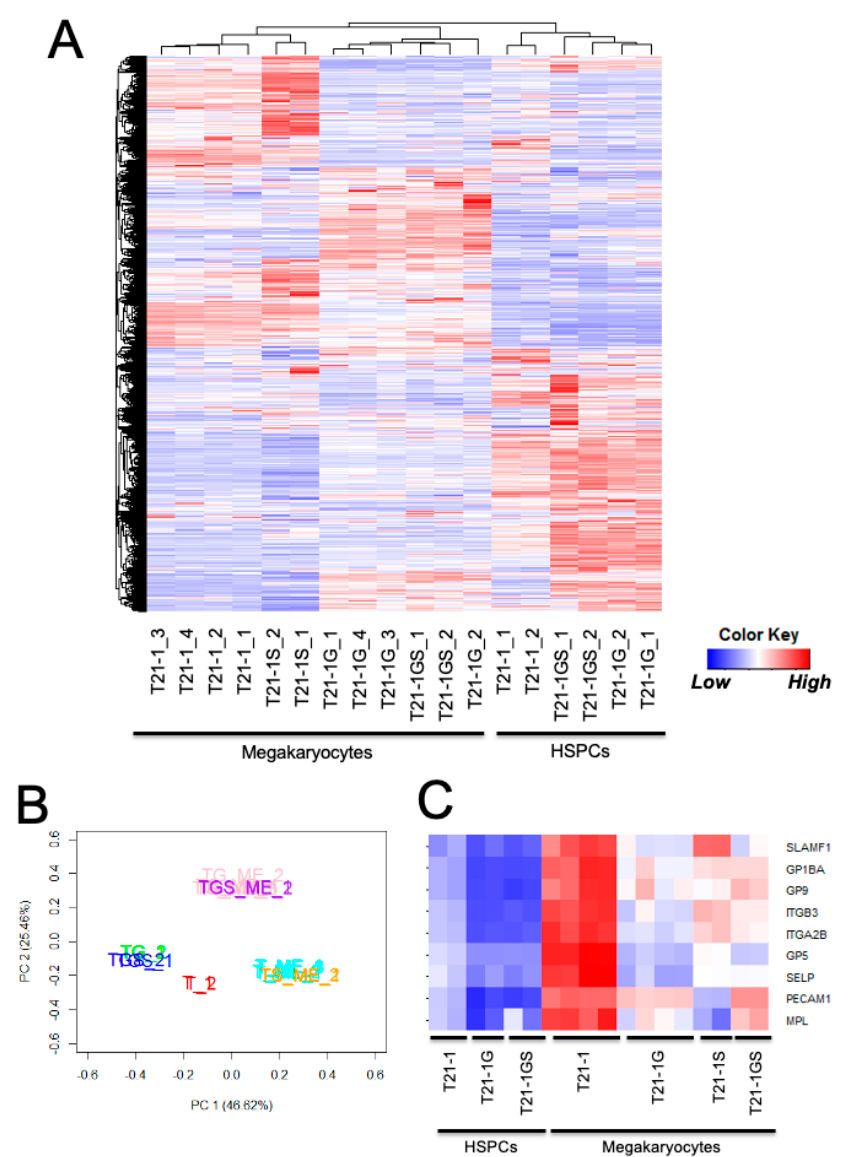
Figure 4. ( A ) Heatmap showing the unsupervised hierarchical clustering of all samples. ( B ) Principal component analysis of the indicated samples. T21-1 HSPCs (T_1,2 in red), T21-1G HSPCs (TG_1,2 in green), T21-1GS (TGS_1,2 in blue), T21-1 megakaryocytes (T_ME_1,2 in teal), T21-1G megakaryocytes (TG_ME_1,2 in pink), T21-1S (TS_ME_1,2 in yellow), T21-1GS (TGS_ME_1,2 in magenta). All genes were used for both analyses. ( C ) Heatmap showing the expression of megakaryocyte markers.